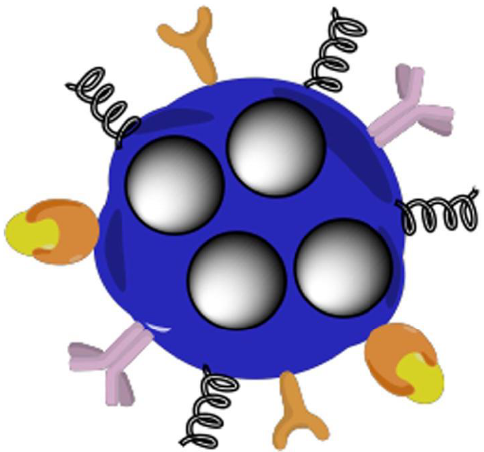
Figure 2. Representation of a smart multifunctional drug-loaded nanoparticle, decorated with various moieties for targeting, imaging and stealth properties. This image is reprinted under a Creative Commons CC BY 4.0 license from [53].